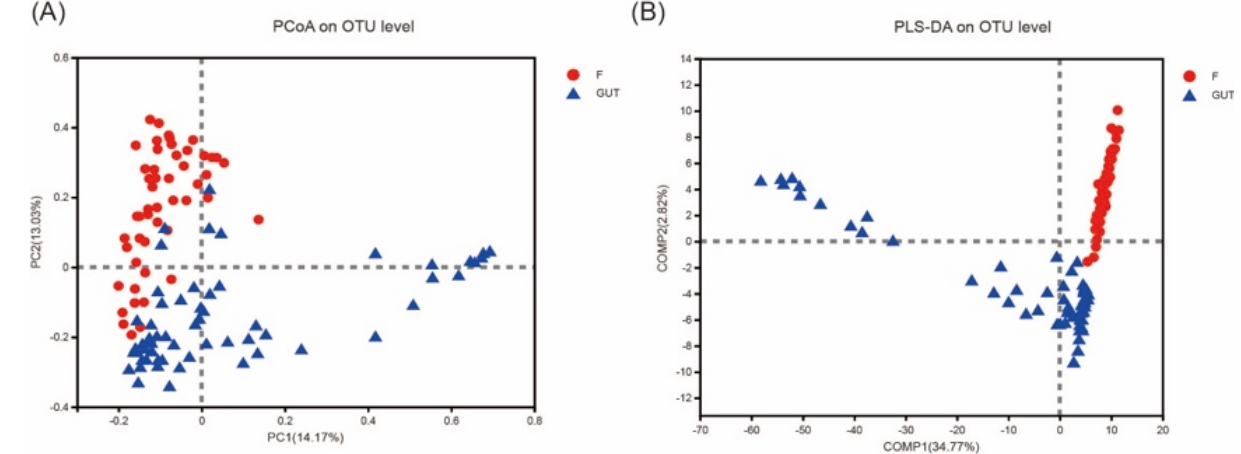
Figure 3. β− diversities of the gut microbiome in MDD and control cases. ( A ) Principal component analysis (PCoA) plot generated from the weighted UniFrac analysis. The x − axis indicates the first coordinate (PC1), and the y − axis indicates the second coordinate (PC2). The values in parentheses are the percentages of the community variation explained. The red and blue dots depict microbial enrichment in the MDD (F) and control (GUT) groups, respectively. ( B ) Partial least squares discriminant analysis (PLS − DA) of the MDD (F, red) and control (GUT, blue) groups.